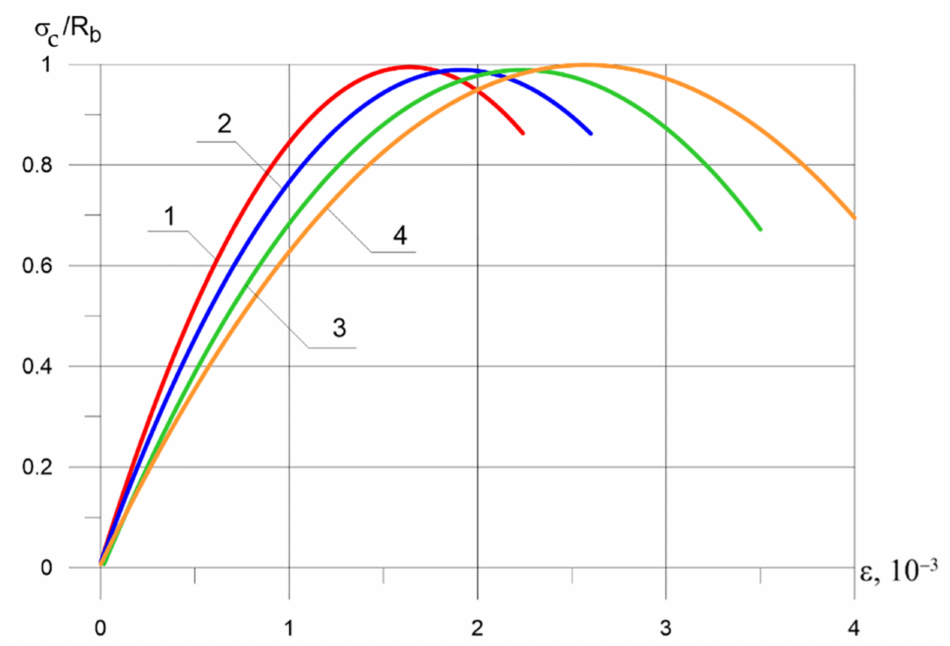
Figure 5. The stress–strain diagram (compression test results for prism specimens): 1, 3—heavy concrete and expanded clay concrete; 2, 4—also with